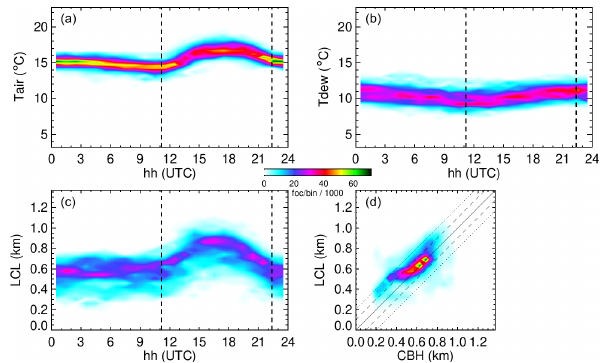
Figure 17. Air temperature at 2m (a) , dew point (b) , and lifting condensation level (LCL, c ) versus hour and LCL versus cloud- base heights from Cloudnet (CBHs, d ). All quantities during winter (JJA), presented as two-dimensional frequency distributions. Ver- tical dashed lines indicate the average times of sunrise and sun- set, respectively. Diagonal lines in (d) indicate ± 100 (dashed) and ± 200m (dotted) deviations from perfect